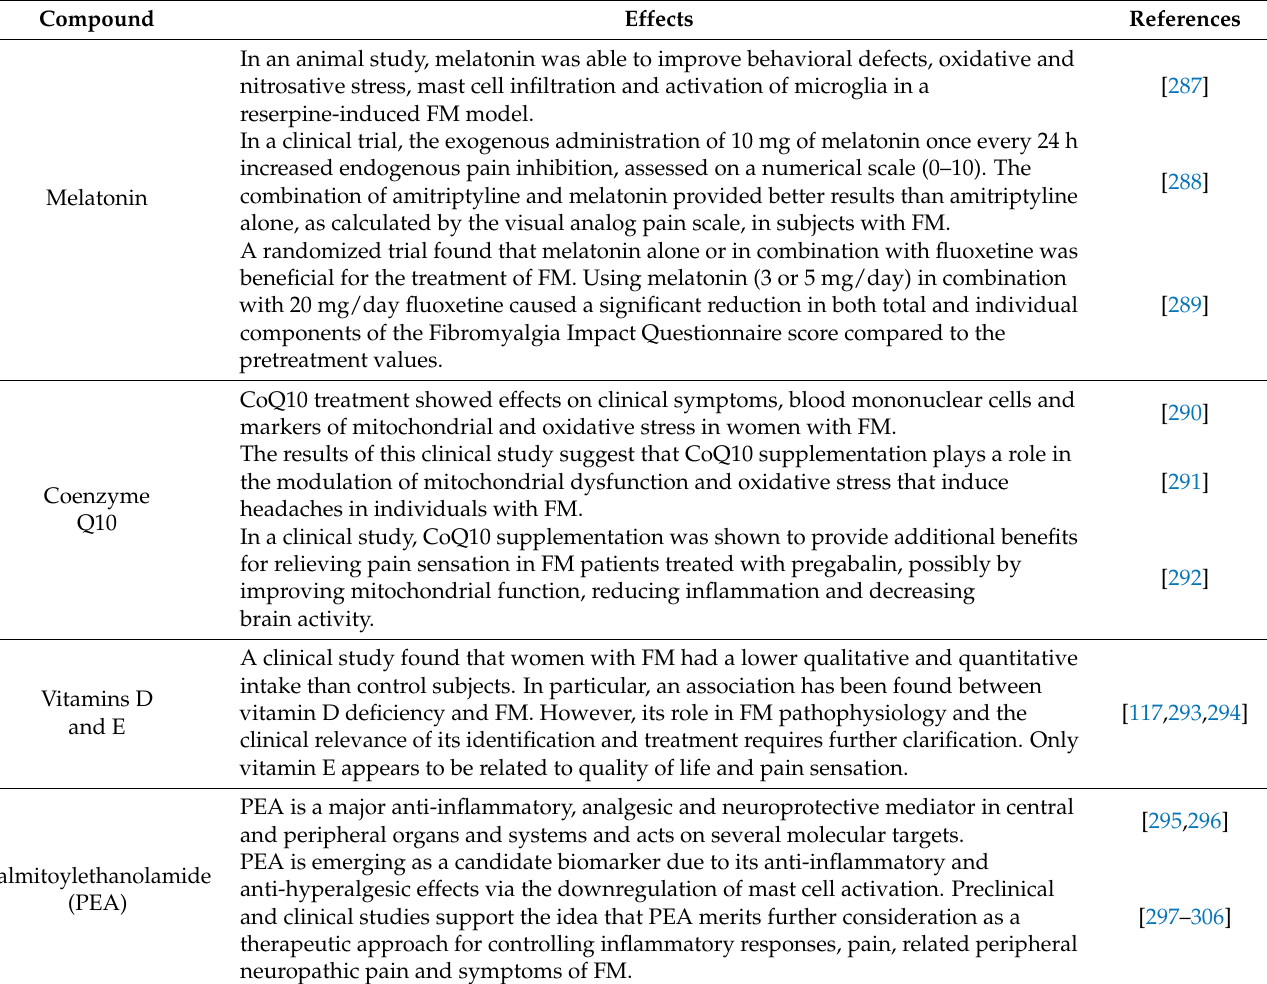
Table 3. Compounds with antioxidant and analgesic properties for FM management.